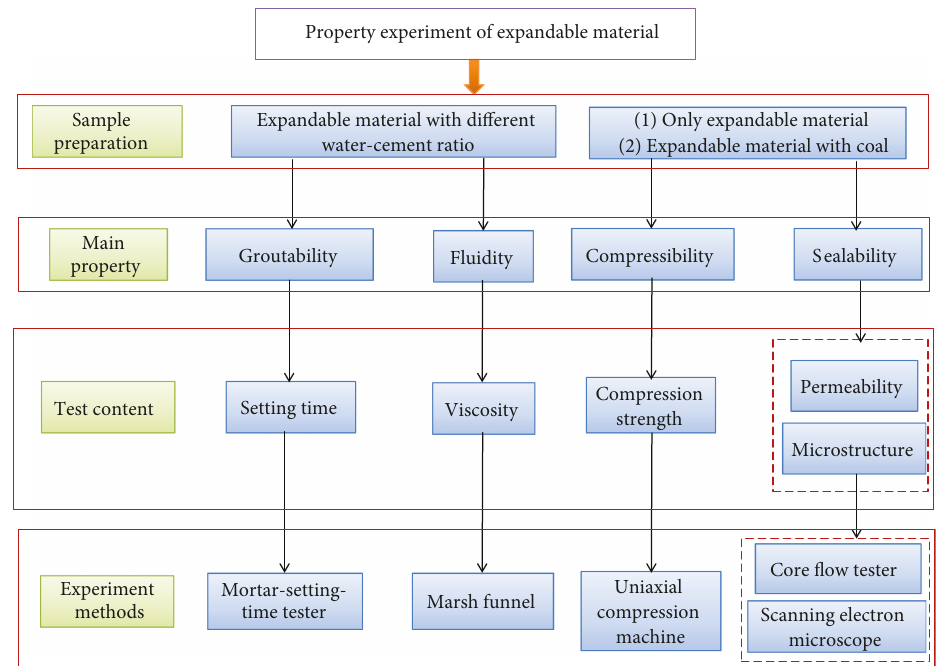
Figure 3: Experimental procedures to study the properties of the expandable material with high water